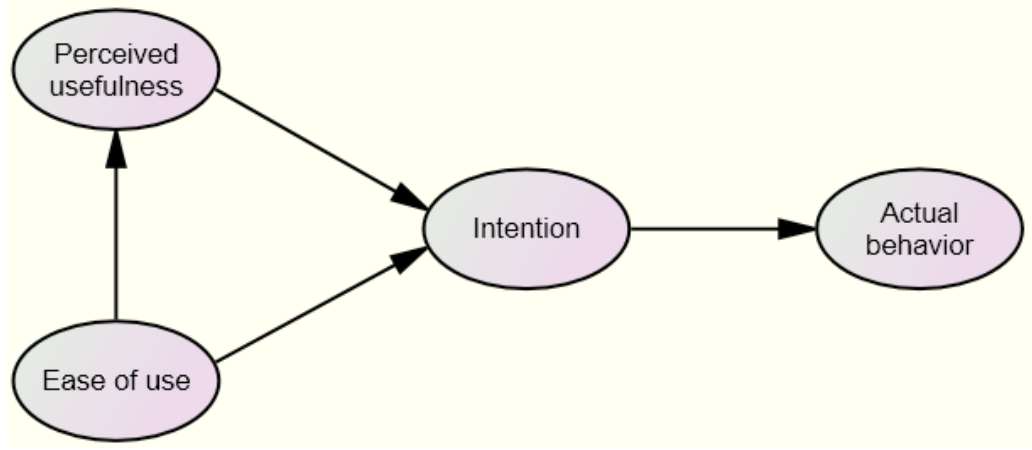
Figure 1. Technology acceptance model (TAM) (Source: Davis et al.,